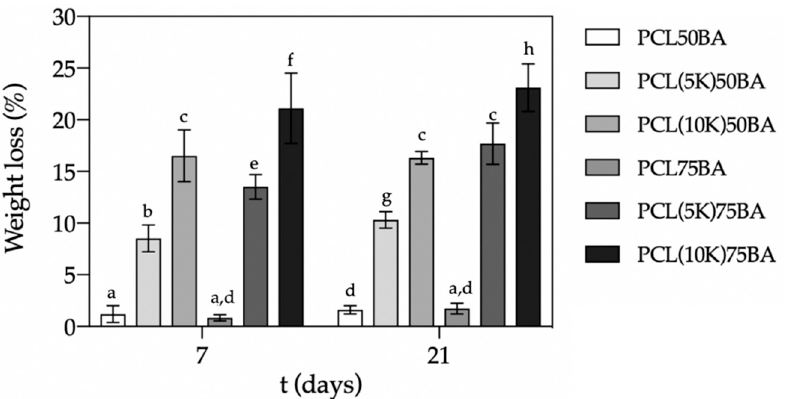
Figure 6. Weight losses of PCL scaffolds after 7 and 21 days in PBS pH 7.4 medium at 37 °C and 60 rpm. Equal letter denotes statistically homogeneous groups (1-way ANOVA; p < 0.05).